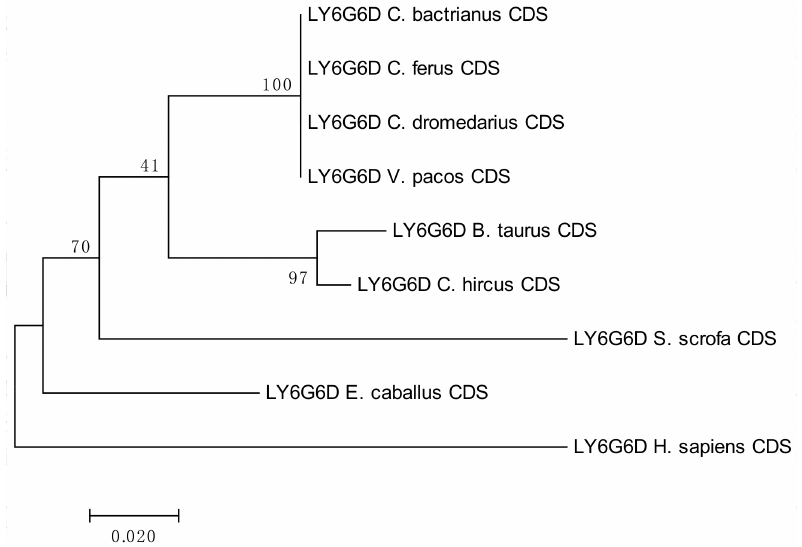
Figure 4. Phylogenetic tree of the LY6G6D CDSs from selected species. The maximum-likelihood method was used based on the Kimura 2-parameter model. The number of bootstraps was